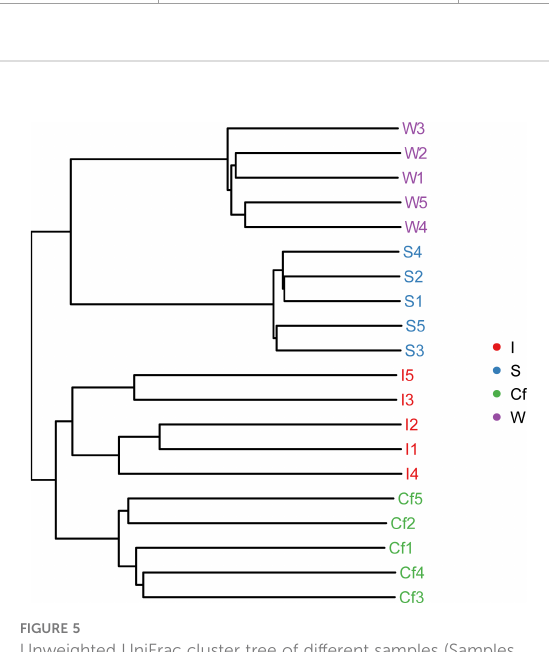
FIGURE 5 Unweighted UniFrac cluster tree of different samples (Samples with the same color in the graph indicate that they belong to the same group. The closer the samples are, the shorter the branch lengths are, indicating that the species composition of the two samples is more similar.).